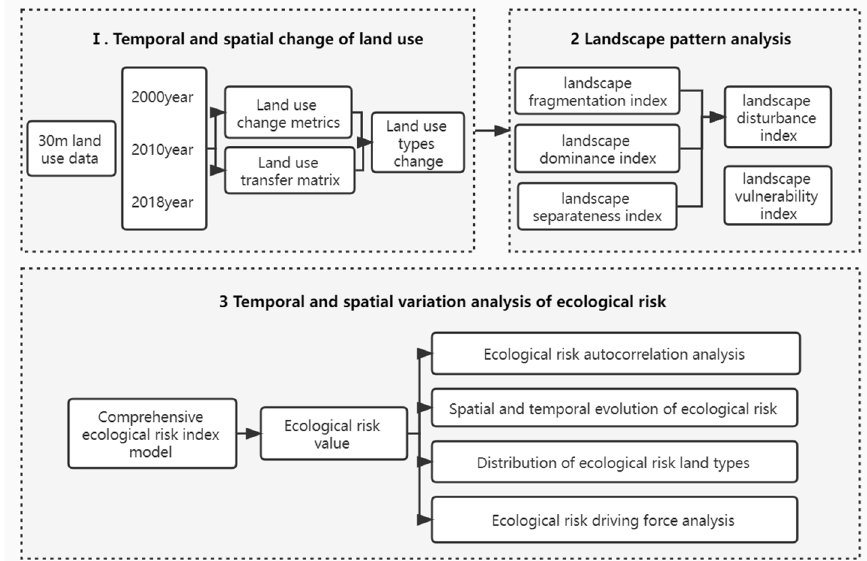
Figure 3. The framework of the research.